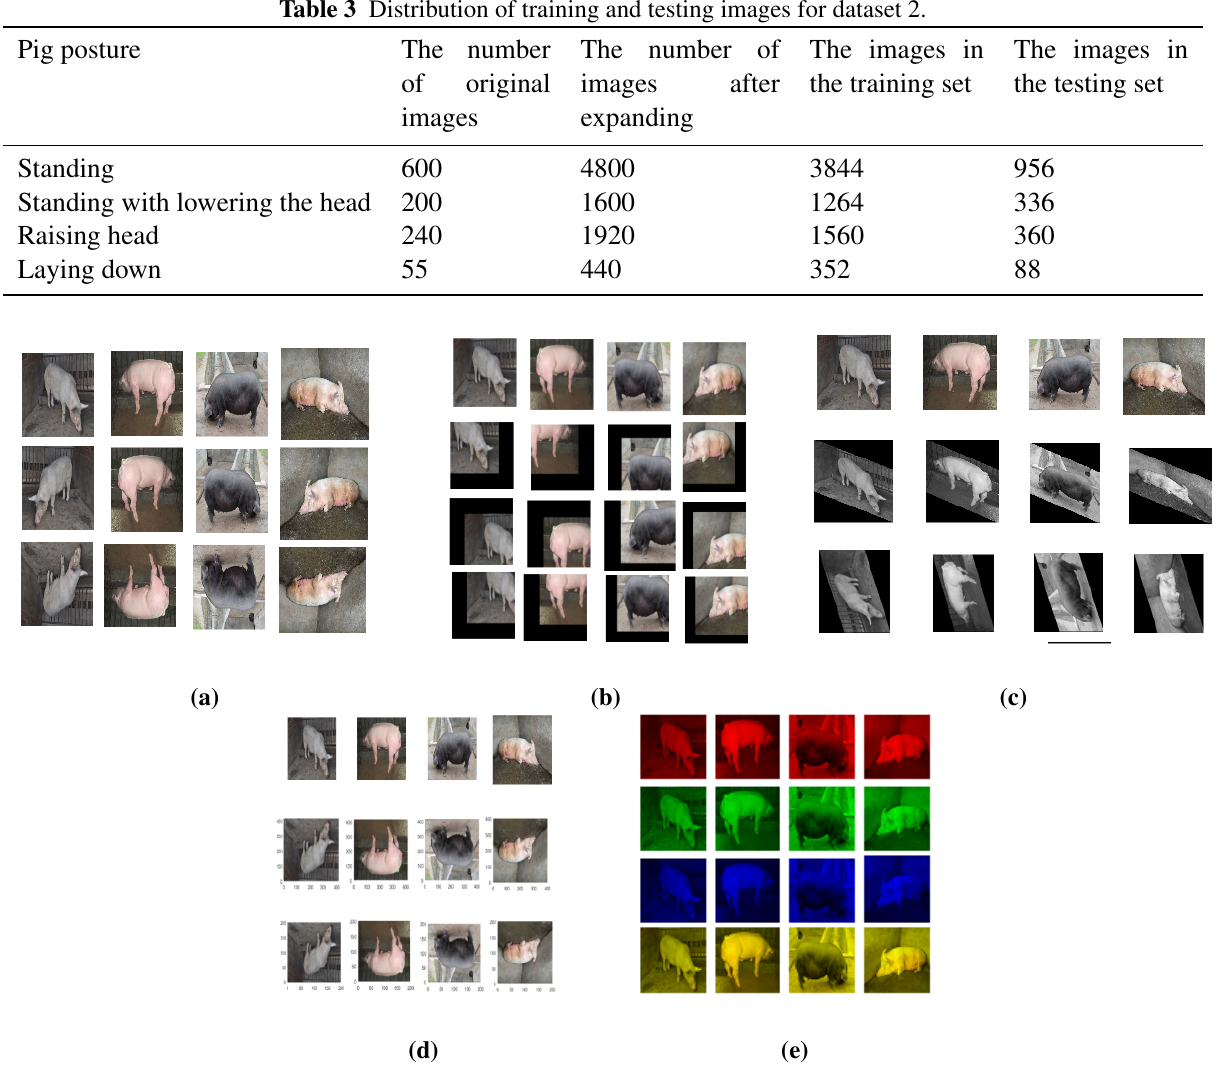
Fig. 8 Rotation of driving wheels around the pipe